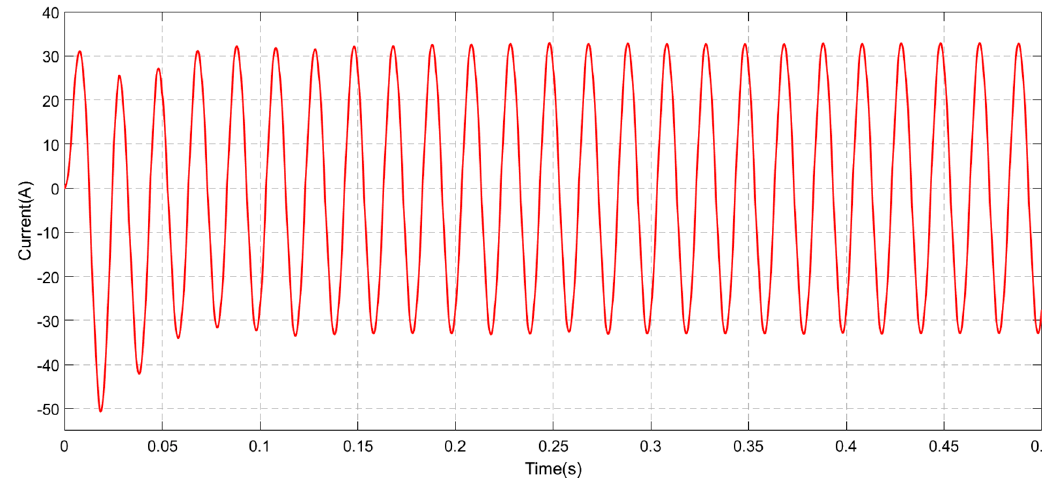
Figure 16. Waveform of load current with PV inverter.